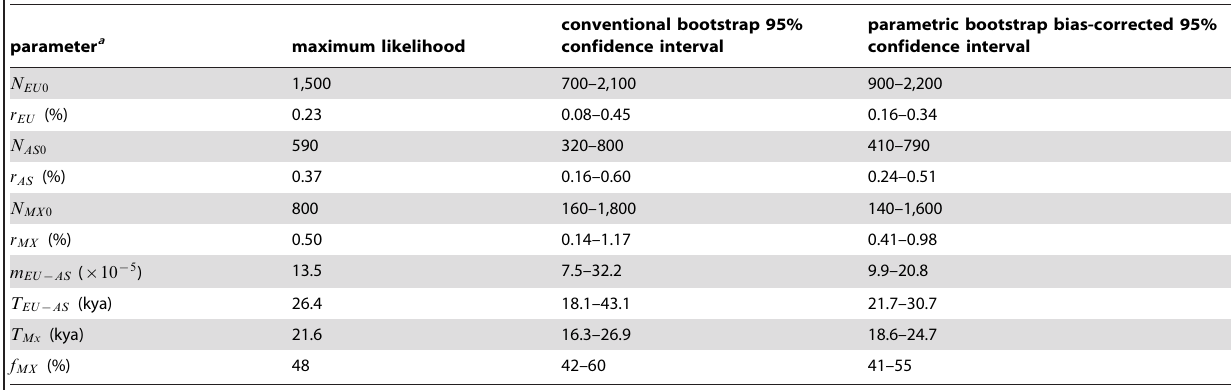
a See Figure 3B for model schematic. Growth rates r and migration rates m are per generation. f MX is the average European admixture proportion of the Mexican- Americans sampled.